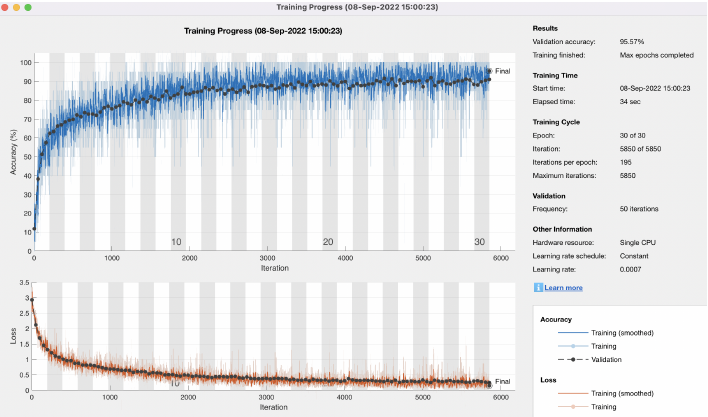
Figure 14. This figure shows the trend of the training progress in the case of a subarea in which the lambda value is equal to 4%.